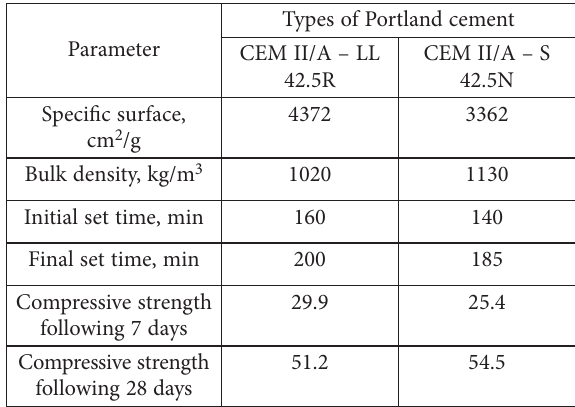
Table 1. Physical and mechanical properties of Portland cement